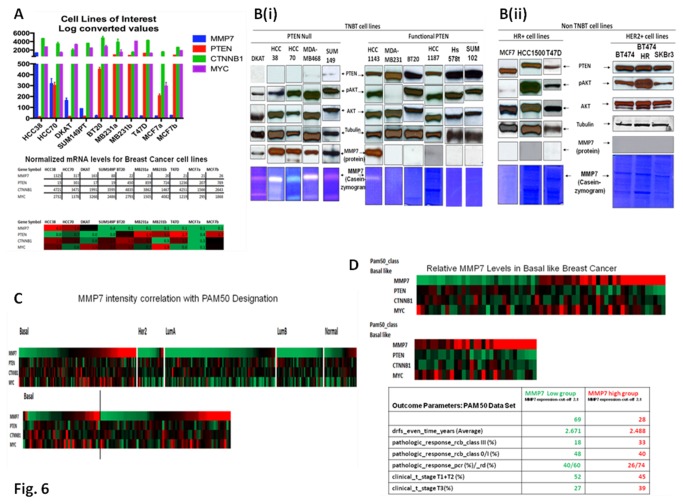
Relationship between MMP7 expression and PTEN expression in TN tumors and cell lines, and MMP7 intensity correlation with PAM50 designation.Relationship between MMP7 expression and PTEN expression in TN tumors and cell lines (A and B), and MMP7 intensity correlation with PAM50 designation (C and D) are presented. A. Cell lines were downloaded from GEO (GD3285) with replicates averaged for each cell line. HCC38 and SUM149PT did not have replicates. Error bars represent the coefficient of variation between each of the replicates. MDA-MB231 and MCF7 cell lines had two distinct groups of replicates that are included on this graph to demonstrate the variability standard cell lines can have (most likely due to passage number differences). Relative levels of expression of MMP7 and PTEN mRNAs (published DASL intensities) from different TN cell lines showing a differential expression of high MMP7 in the TN (HCC38, HCC70, MDA-MB231, BT20, DKAT and SUM149T) cell lines as compared to non-TN cell lines (MCF7, T47D) as shown in the upper panel. Normalized mRNA levels for breast cancer cell lines show that the presence of a higher level of MMP7 mRNA in the individual TN cell lines is associated with relatively lower levels of PTEN mRNA. These reciprocal levels of expression of MMP7 to the PTEN mRNAs (DASL intensities) were observed in heat map of gene expression as shown in the lower panel. Cell line intensity data generated from Affymetrix Gene Expression arrays (Upper panel). RMA normalized intensity values shows relative inter-gene levels of each mRNA in a specific cell line with the (Lower panel) heat map using Z’ values calculated for each specific gene to visualize intra-gene mRNA levels. B (i). Expression of MMP7 protein and the secretion of functional MMP7 were determined in the PTEN-null and PTEN expressing TNBC cells. High levels of expression of MMP7 protein and the secretion of functional MMP7 (casein zymogram from the conditioned media) in TNBC cells is inversely related to the presence of functional PTEN (protein expression as well as pAKT). B (ii). Expression of MMP7 protein and the secretion of functional MMP7 were determined in the PTEN expressing non-TNBC cells (HR+ and HER2 over-expressed). C. Patient downloaded from GEO (GSE25055). Top panel showing PAM50 designations used to separate the patients into each subtype. Each subtype was then sorted from left to right by increasing MMP7 intensity. Bottom panel is sorted by increasing MMP7 from left to right. Bold vertical line separates pCR on the left with residual disease (RD) on the right. D. Heat Map of expression of mRNAs for MMP7, PTEN, CTNNB1, c-MYC genes (PAM50 data) in Basal, HER2E and HR+ subsets of BC. Table (Lower panel) shows the outcome data for triple negative breast cancer patients from PAM50 data set with high MMP7, and low MMP7. Patient data from Fig. 6C were further examined for basal-like subtype using Z’ scores. Top panel shows increasing MMP7 Z’ score from left to right for all patient samples. Middle panel displays only patients with Z’ scores over 2.0 for MMP7, which shows the association with high MMP7 levels and low PTEN levels. The outcome data for the patients expressing low-MMP7 and high-MMP7 in their tumors are shown in the table (Lower panel).